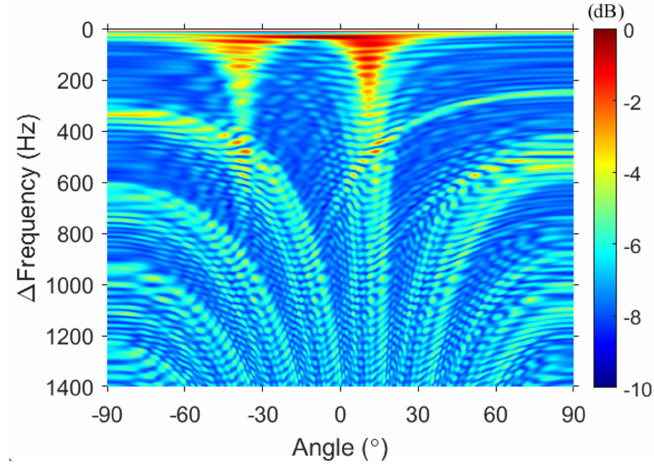
Figure 7. FD beamforming of experimental data. Overall, the outputs of FD beamforming of the simulation (see Fig. 3) and experimental data show good agreement. In the difference frequency range below 400 Hz, two vertical lines are formed, as in the simulation. However, for a difference-frequency band higher than 400 Hz, the angle spread is more severe than that in the simulation. This more severe angle spread may have been caused by (1) the curvature of the array shape because of various factors, such as current, as well as (2) the near-field effect.